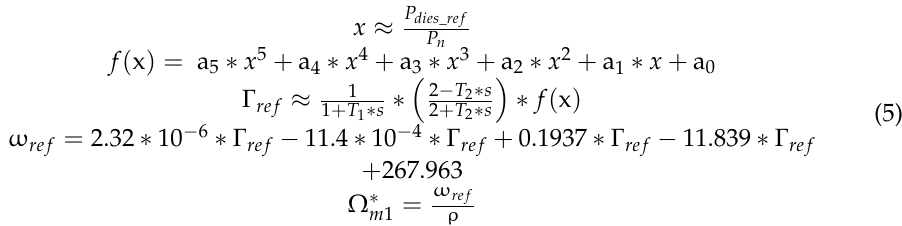
Figure 9. Three-level PWM rectifier control method.